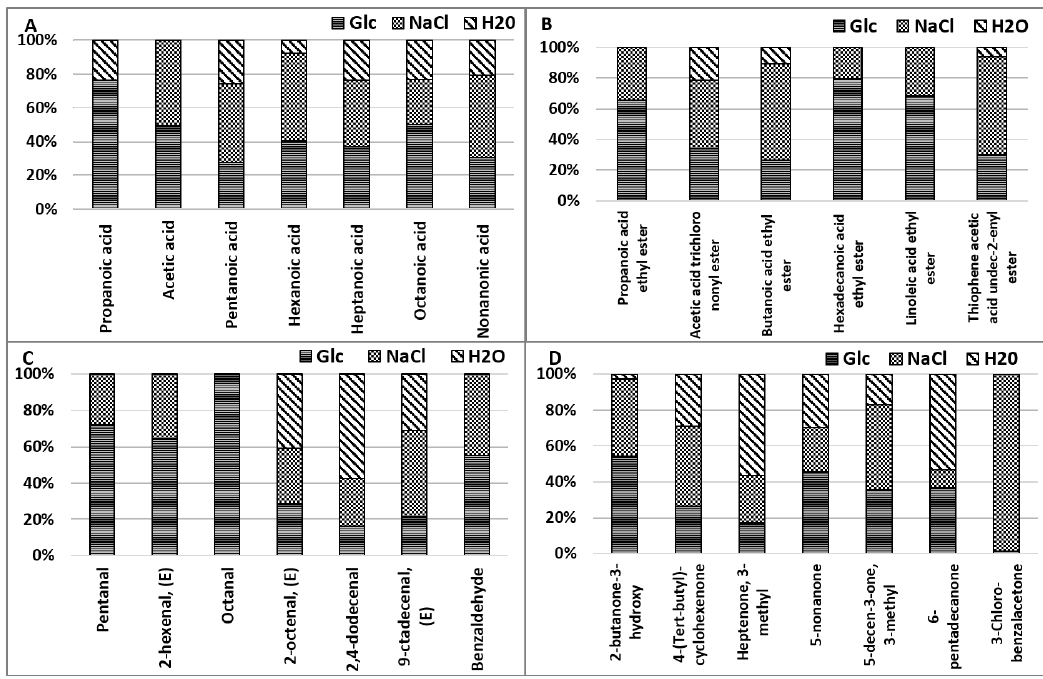
Figure A2. ANOVA plots with categorical predictors set on Z. mobilis strains ( P < 0.01), relative to; ( A ) organic acids; ( B ) esters of organic acids; ( C ) aldehydes; ( D ) ketones. F = not-inoculated leavened doughs; 3580 = Z. mobilis 3580 leavened doughs; 424 = Z. mobilis 424 leavened doughs; 473 = Z. mobilis 473 leavened doughs.